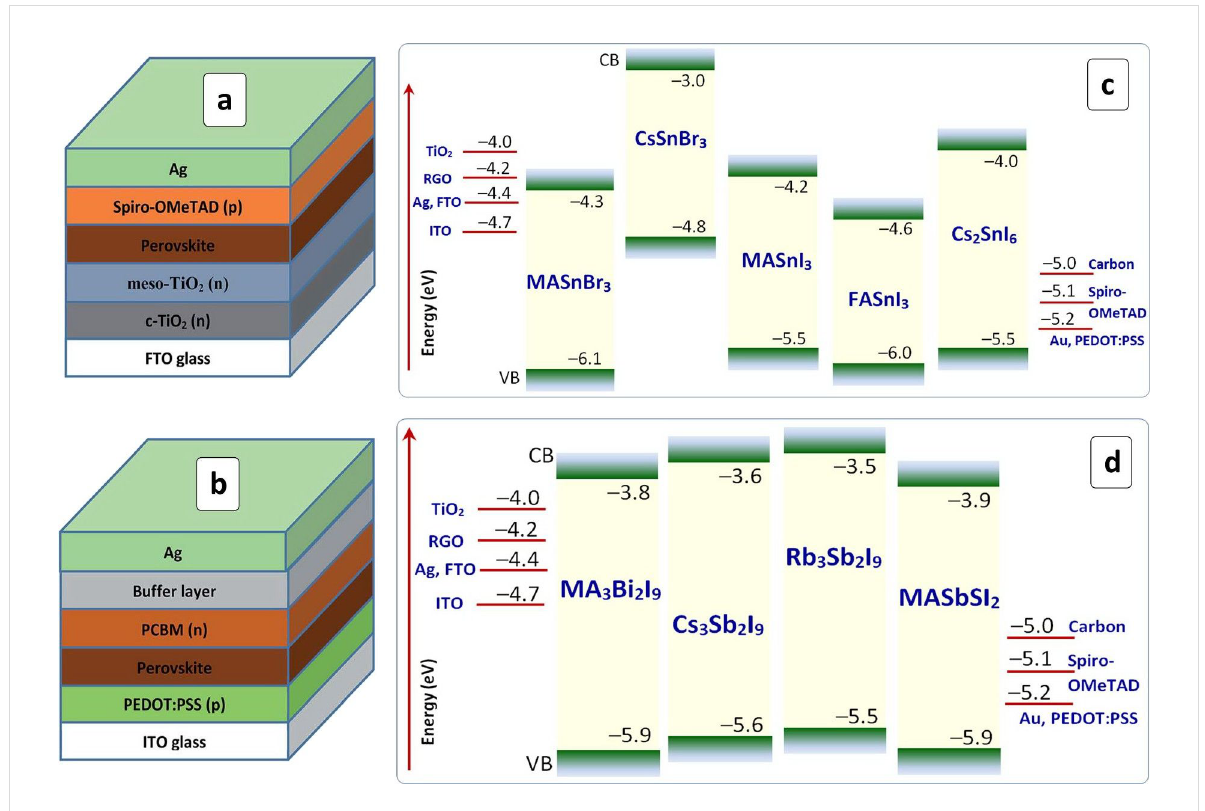
Figure 2: Schemes of conventional (a) and inverted (b) HP-based solar cell; energy diagrams of selected Sn-based HPs (c) and Bi- and Sb-based HPs (d) relative to the levels of some ETL and HTL materials. The CB/VB levels are taken from [78] (MASnBr 3 ), [79] (CsSnBr 3 ), [80,81] (MASnI 3 ), [80,82] (FASnI 3 ), and [80,83] (Cs 2 SnI 6 ), [67-86] (MA 3 Bi 2 I 9 ), [87] (MASbSI 2 ), [88-90] (Cs 3 Sb 2 I 9 ), and [91] (Rb 3 Sb 2 I 9 ). (a,b) Reprinted with permission from [27], copyright 2018 The Royal Society of